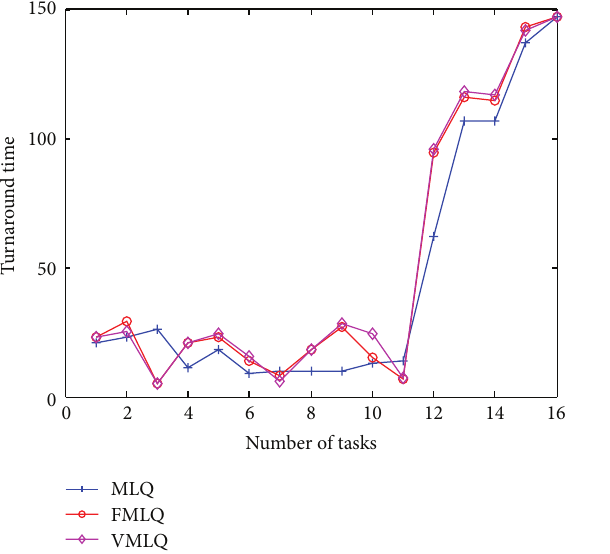
Figure 14: Results (sample task set).